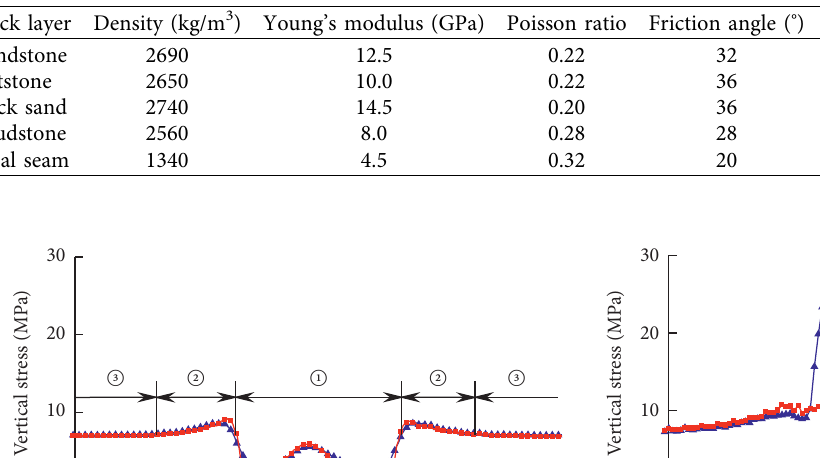
Figure 5: Numerical simulation. (a) Model A (presence of siltstone key strata between two seams). (b) Model B (absence of key strata between two seams). ① Upper seam. ② Lower seam. Table 3: Mechanical parameters of rock layer in the numerical